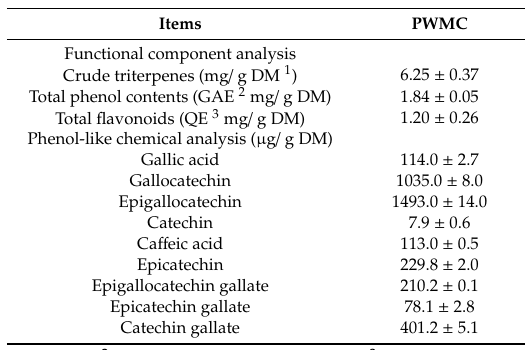
Table 3. The functional chemical composition analysis in PWMC. Items